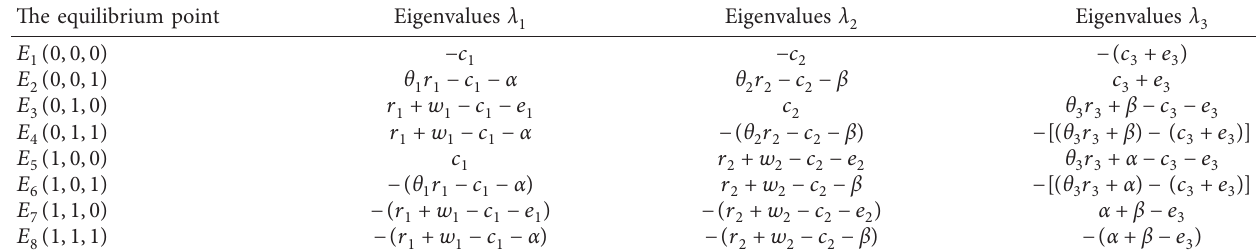
Table 3: The eigenvalues of the equilibrium points.